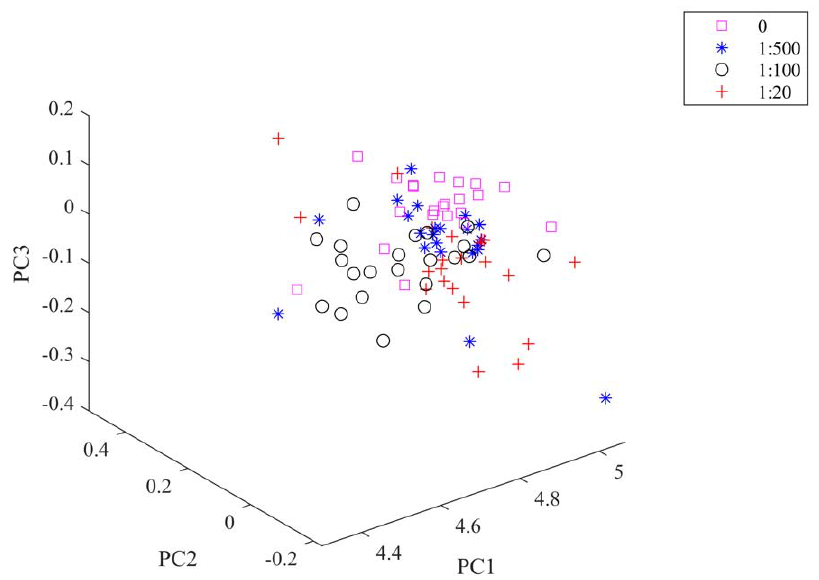
Figure 3. Top three principle components (PCs) for training set samples with no pesticide contami- nation, mild contamination (pesticide water ratio 1:500), moderate contamination (pesticide water ratio 1:100), and severe contamination (pesticide water ratio 1:20).